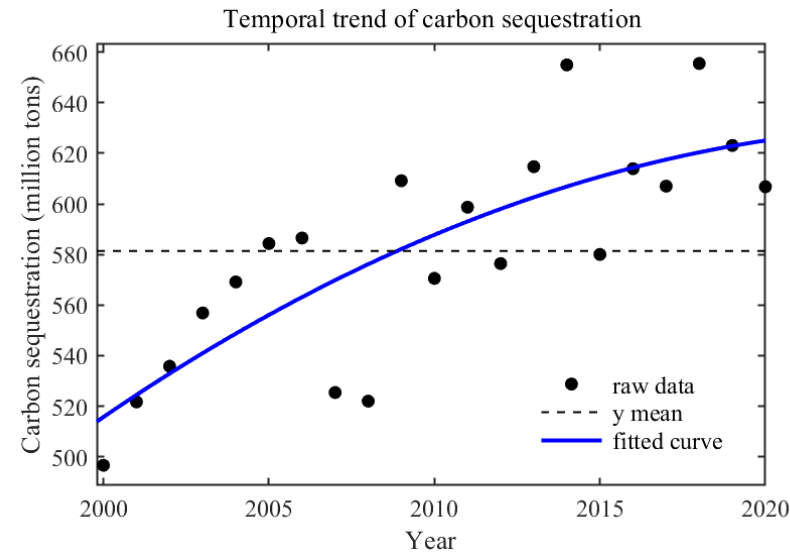
Figure 2. Temporal trends of carbon sequestration.